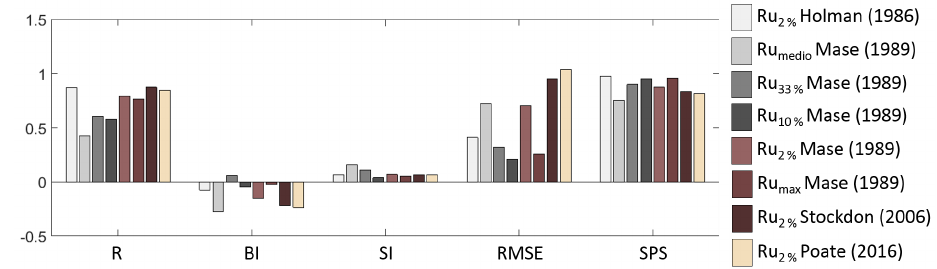
Figure 13. Bar diagram of the statistical parameters R (correlation index), BI (bias), SI (scatter index), RMSE (root-mean-square error) and SPS (summary performance score), obtained comparing the run-up video camera observations with the same parameter calculated using the empirical formulas introduced by Holmann (1986), Mase (1989), Stockdon et al. (2006) and Poate et al. (2016).